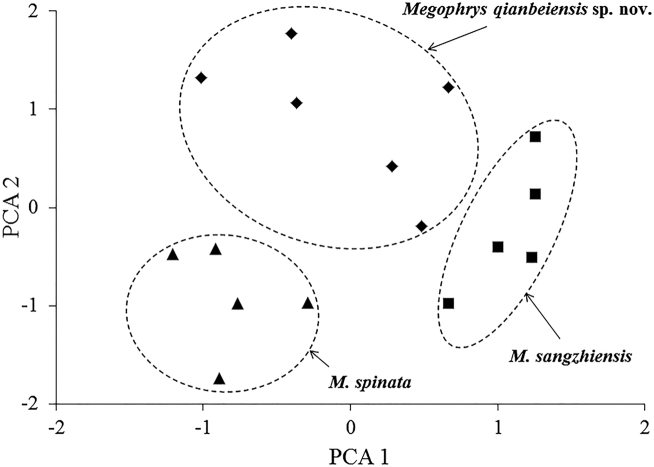
Plots of the first principal component (PCA1) versus the second (PCA2) for Megophrys
qianbeiensis sp. nov., M.
sangzhiensis, and M.
spinata from principal component analyses.